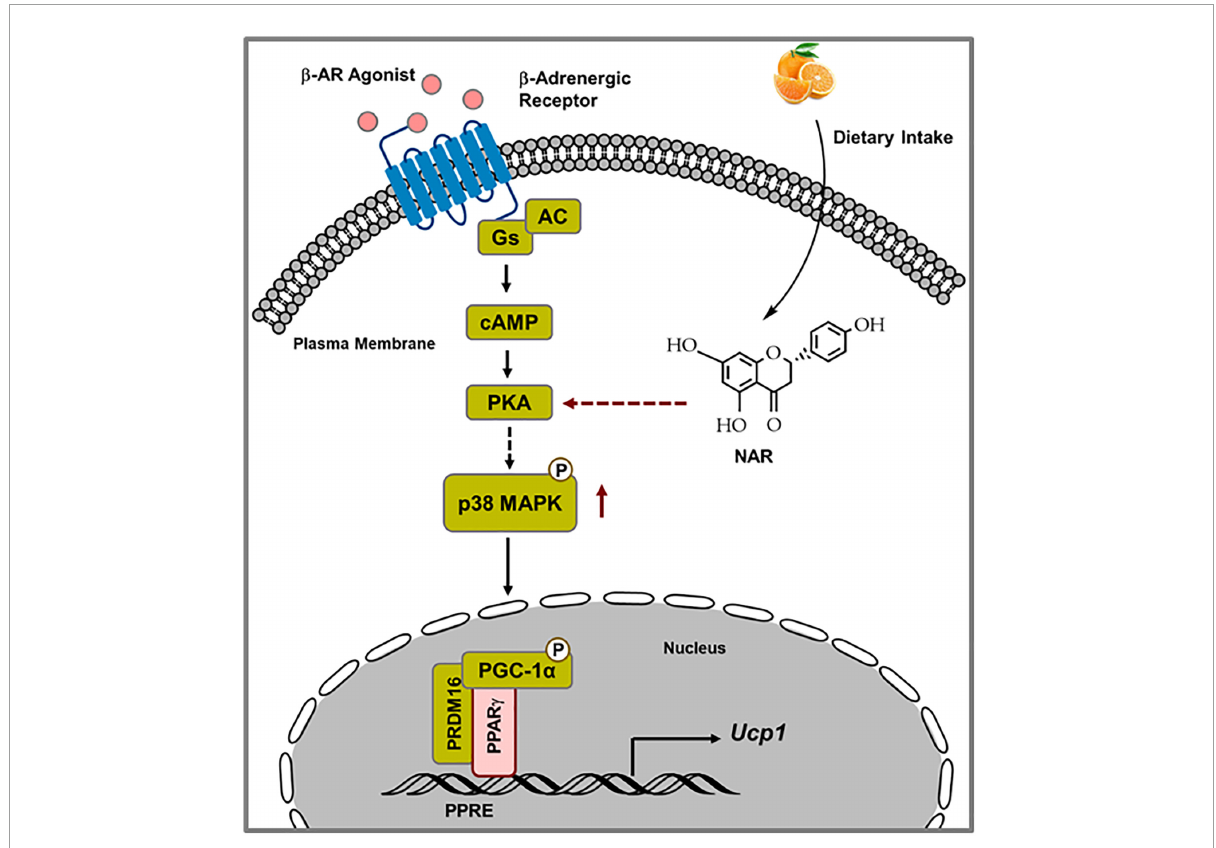
FIGURE9 Schematic diagram illustrating the proposed mechanisms by which naringenin enhances isoproterenol (ISO)-stimulated UCP1 expression in 3T3-L1 adipocytes. Upon ISO binding to the β -adrenergic receptor (AR), cAMP is produced through Gs-coupled adenylyl cyclase (AC), leading to PKA activation. Through yet unknown steps, PKA activation results in p38 phosphorylation and subsequent phosphorylation and activation of downstream targets, such as PGC1 α . Activated PGC1 α co-activates PPAR γ on the PPRE site in the promoter of the Ucp1 gene, leading to enhanced Ucp1 transcription. NAR enhances ISO-stimulated PKA activation and p38 phosphorylation and further activates PPAR γ , leading to increased Ucp1 up-regulation upon ISO stimulation in 3T3-L1